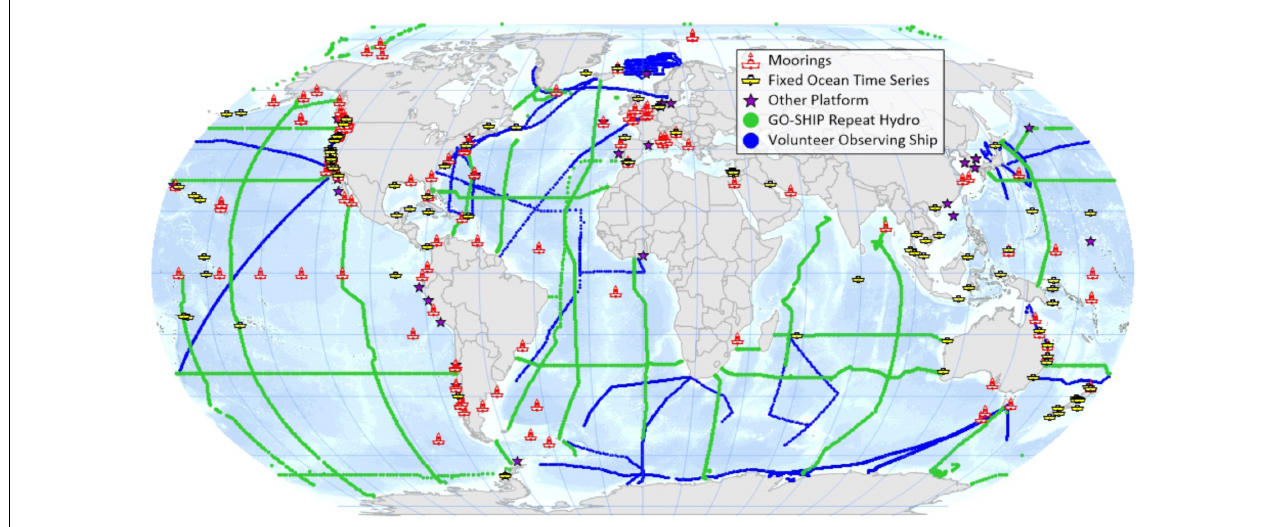
FIGURE 5 | Present-day (as of April 2019) Global Ocean Acidification Observing Network which is collaborative with the GO-SHIP, Ocean SITES, SOCONET, SOOP communities and other open-ocean and coastal observing